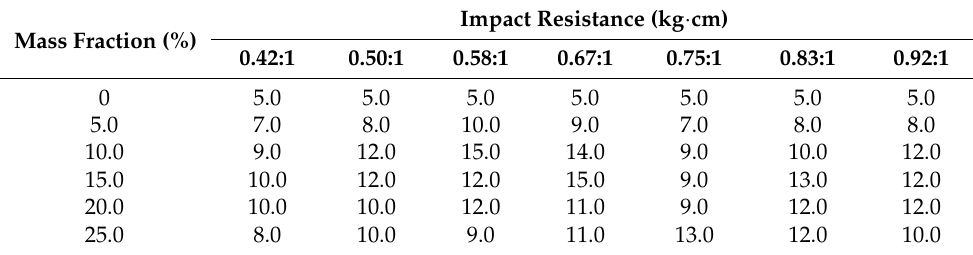
Table 6. Effect of microcapsule concentration and core-shell ratio on the impact resistance of paint